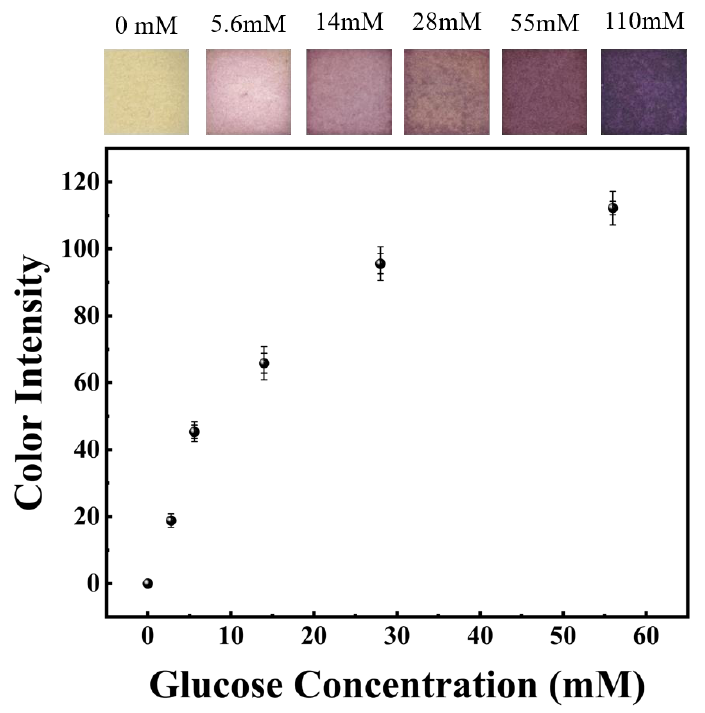
Figure 7. Scanned images of the reaction zone of the paper sensor with different glucose concentra- tions and the average color intensity of the reaction zone.